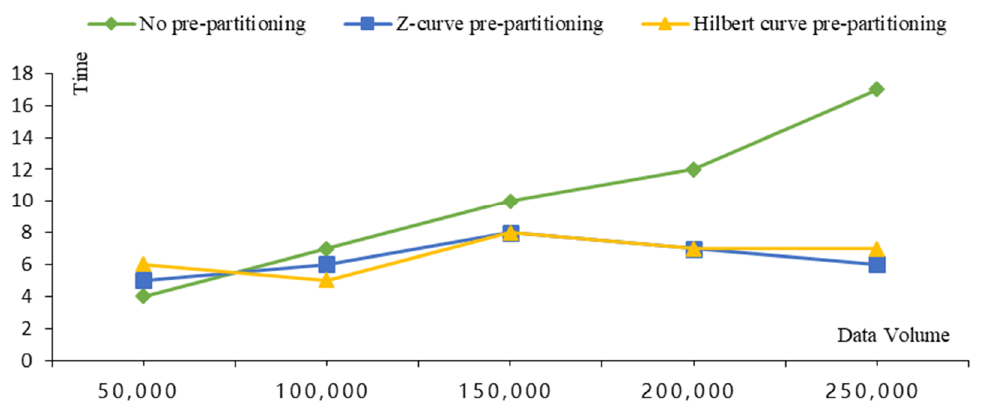
Figure 11. Write speed comparison chart.